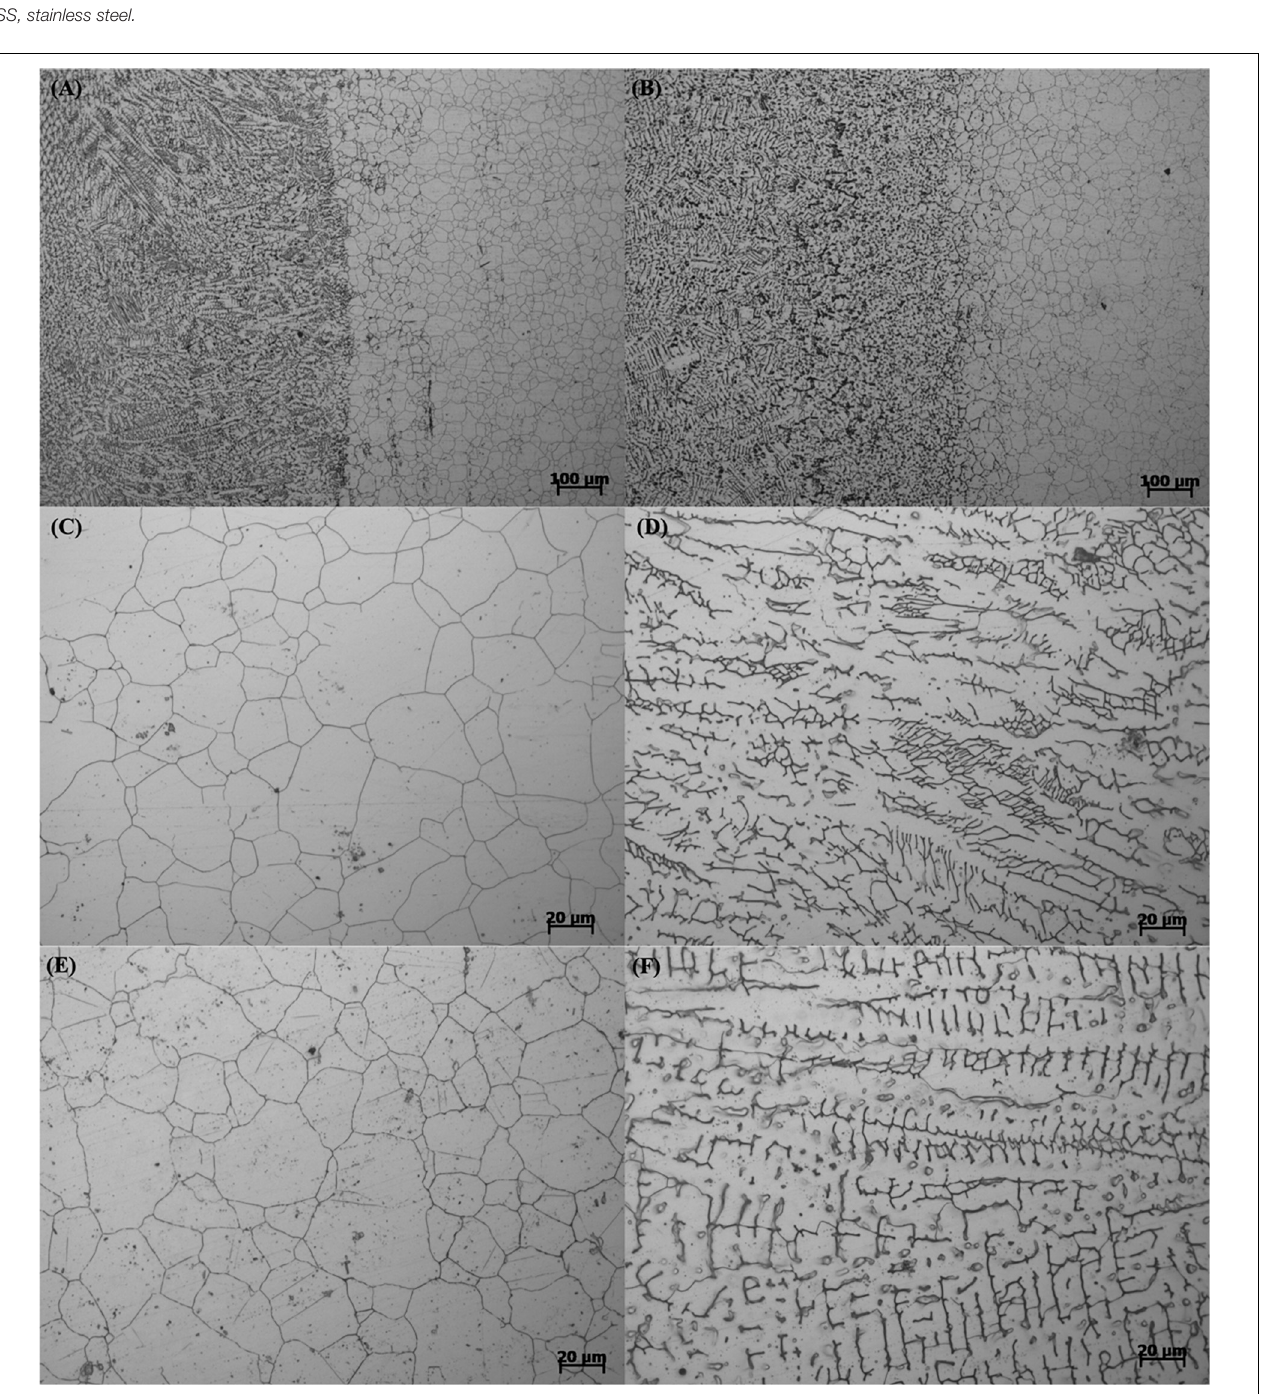
FIGURE 1 | Metallographic microstructure images of (A) welding line of 304L, (B) welding line of 304L-Cu, (C) 304L BM, (D) 304L WZ, (E) 304L-Cu BM, and (F) 304L-Cu WZ. BM, base metal; WZ, welding zone.